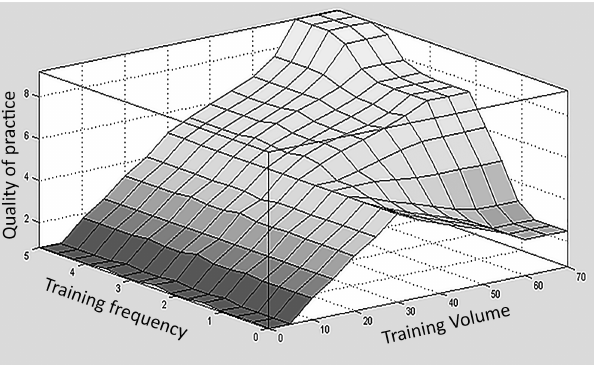
Fig 3. Surface graph representation of the quality of practice in Relation to training frequency and training volume.